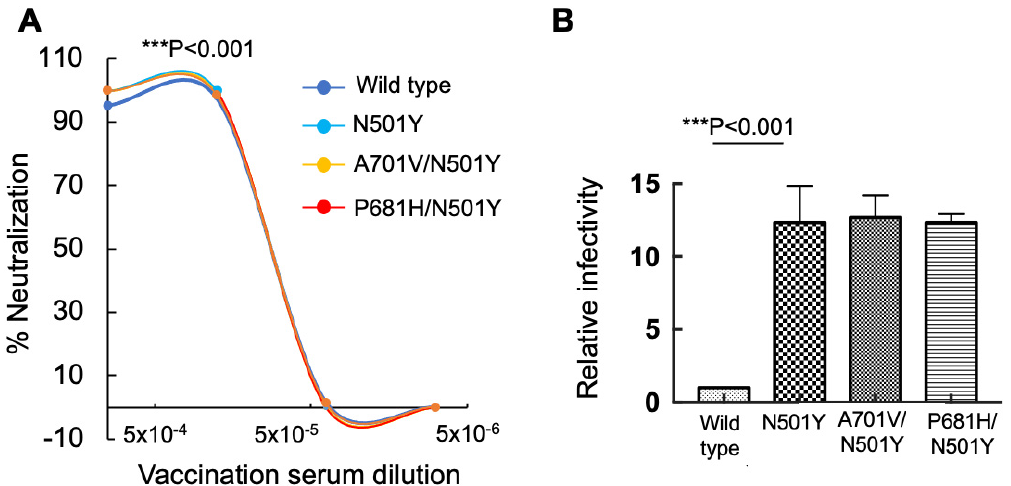
Figure 2. N501Y RBD mutation drives viral infectivity of pseudoviruses carrying Furin Cleavage Site mutations. ( A ) N501Y RBD mutation has no impact on neutralization sensitivity of SARS-CoV-2 that carry a Furin Cleavage Site against post vaccination sera. Neutralization assays were performed by transducing HEK293T-ACE2 cells with pseudovirus displaying a wild-type SARS-CoV-2 spike. Single N501Y mutation or FCS-P681H/N501Y or A701V/N501Y combined mutations in the presence of increasing dilutions of sera drawn from post-vaccinated individuals. In addition, 48 h post transduction, cells were harvested and their luciferase readings were monitored. Neutralizing potency was calculated at increased serial dilutions, relative to transduced cells with no sera added. Neutralization, NT 50 , is defined as the inverse dilution that achieved 50% neutralization. Results are the average of two independent biological experiments. Triplicates were performed for each tested serum dilution. Black bars represent geometric mean of NT 50 values, indicated at the top. Statistical significance was determined using a one tailed t -test *** < 0.001. ( B ) N501Y RBD mutation enhances viral infectivity of SARS-CoV-2 that carry a Furin Cleavage Site. Pseudoviruses carrying wild-type SARS-CoV-2 spike, single N501Y, or the double P681H/N501Y or A701V/N501Y mutations were used to transduce HEK293T-ACE2 cells. Equal viral loads were normalized based on p24 protein levels. In addition, 48 h post transduction, cells were harvested and their luciferase readouts were monitored. Bar graphs show mean values ± SD error bars of three independent experiments. Measured statistical significance was calculated between experiments by a two-tailed Student’s t test *** p ≤ 0.001.